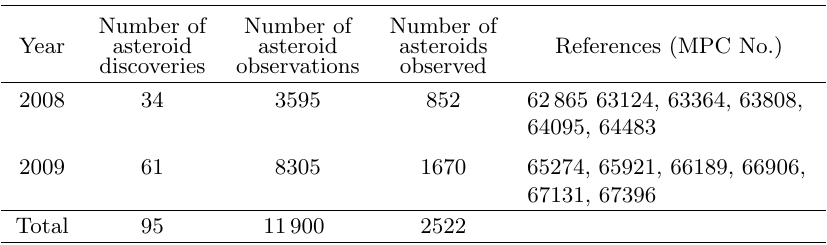
Table 1. Statistics of asteroid discoveries and astrometric observations of the asteroids (both new and known) at the Mol˙etai Observatory in 2008–2009. Number of Number of Number of Year asteroid asteroid asteroids References (MPC No.) discoveries observations observed 2008 34 3595 852 62 865 63124, 63364, 63808, 64095, 64483 2009 61 8305 1670 65274, 65921, 66189, 66906, 67131, 67396 Total 95 11 900